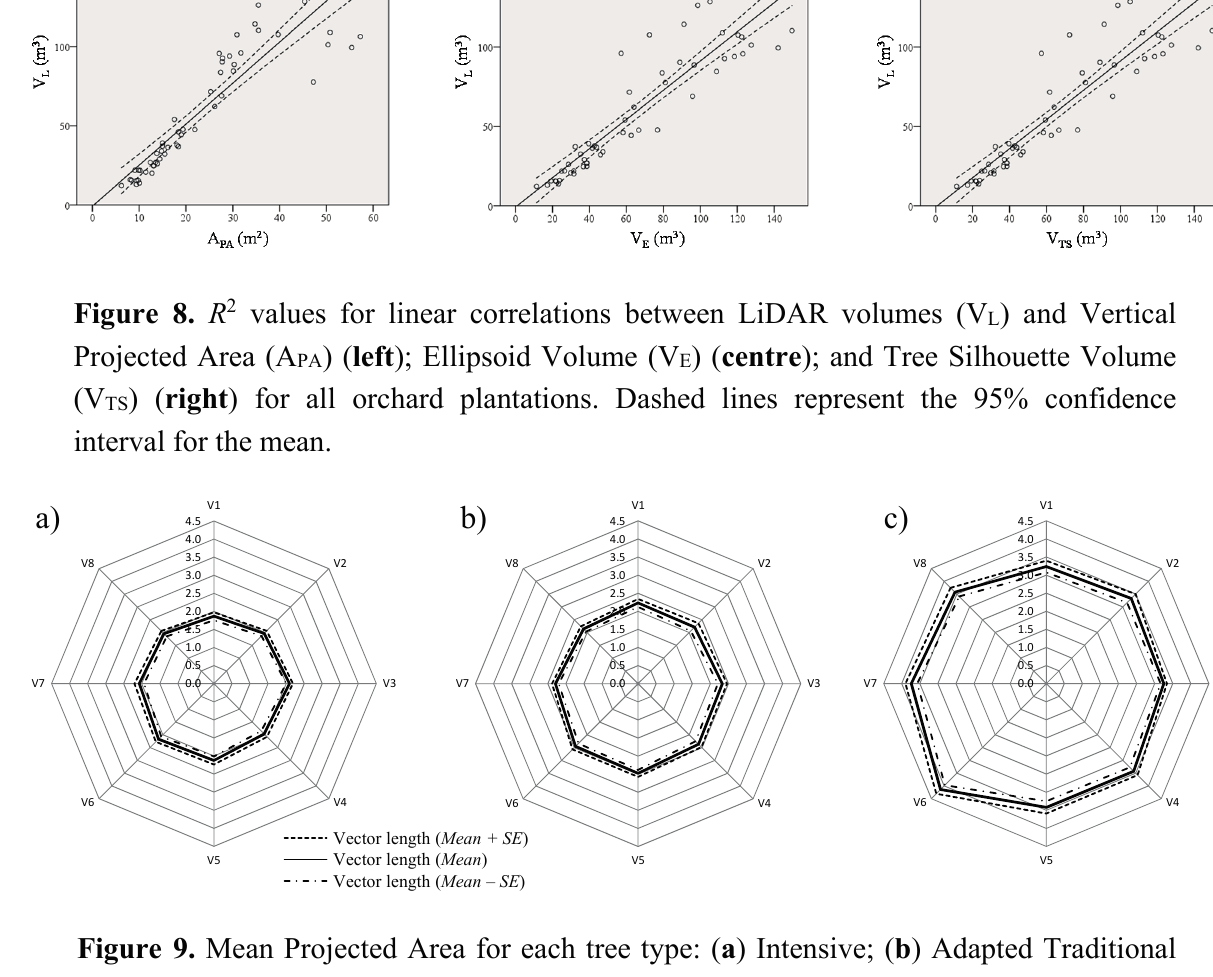
Figure 9. Mean Projected Area for each tree type: ( a ) Intensive; ( b ) Adapted Traditional and ( c ) Traditional. Graphical representation of Vertical Projected Area (A PA )